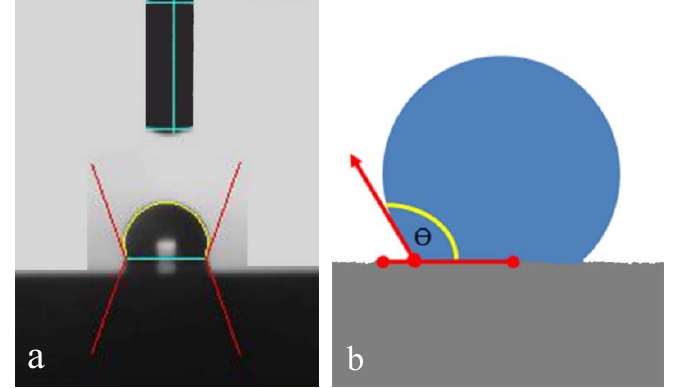
Figure 3. Image of the drop deposition on the surface of the disk ( a ) and a schematic image showing the measuring of the contact angle formed between the drop and the disk surface ( b ).